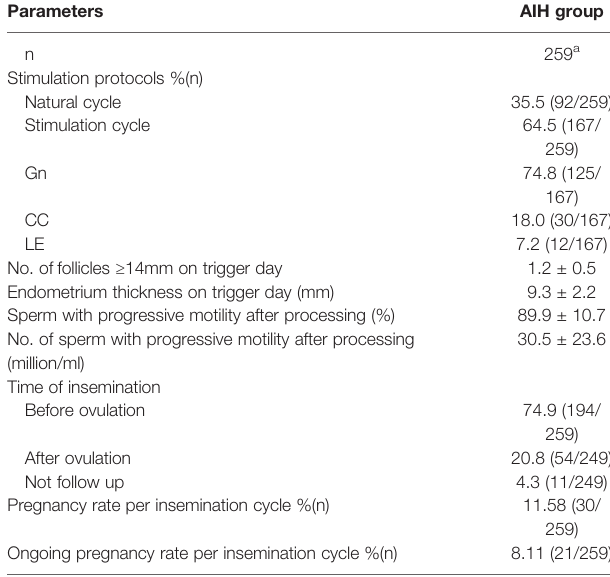
TABLE 3 | Cycle Characteristics of the AIH